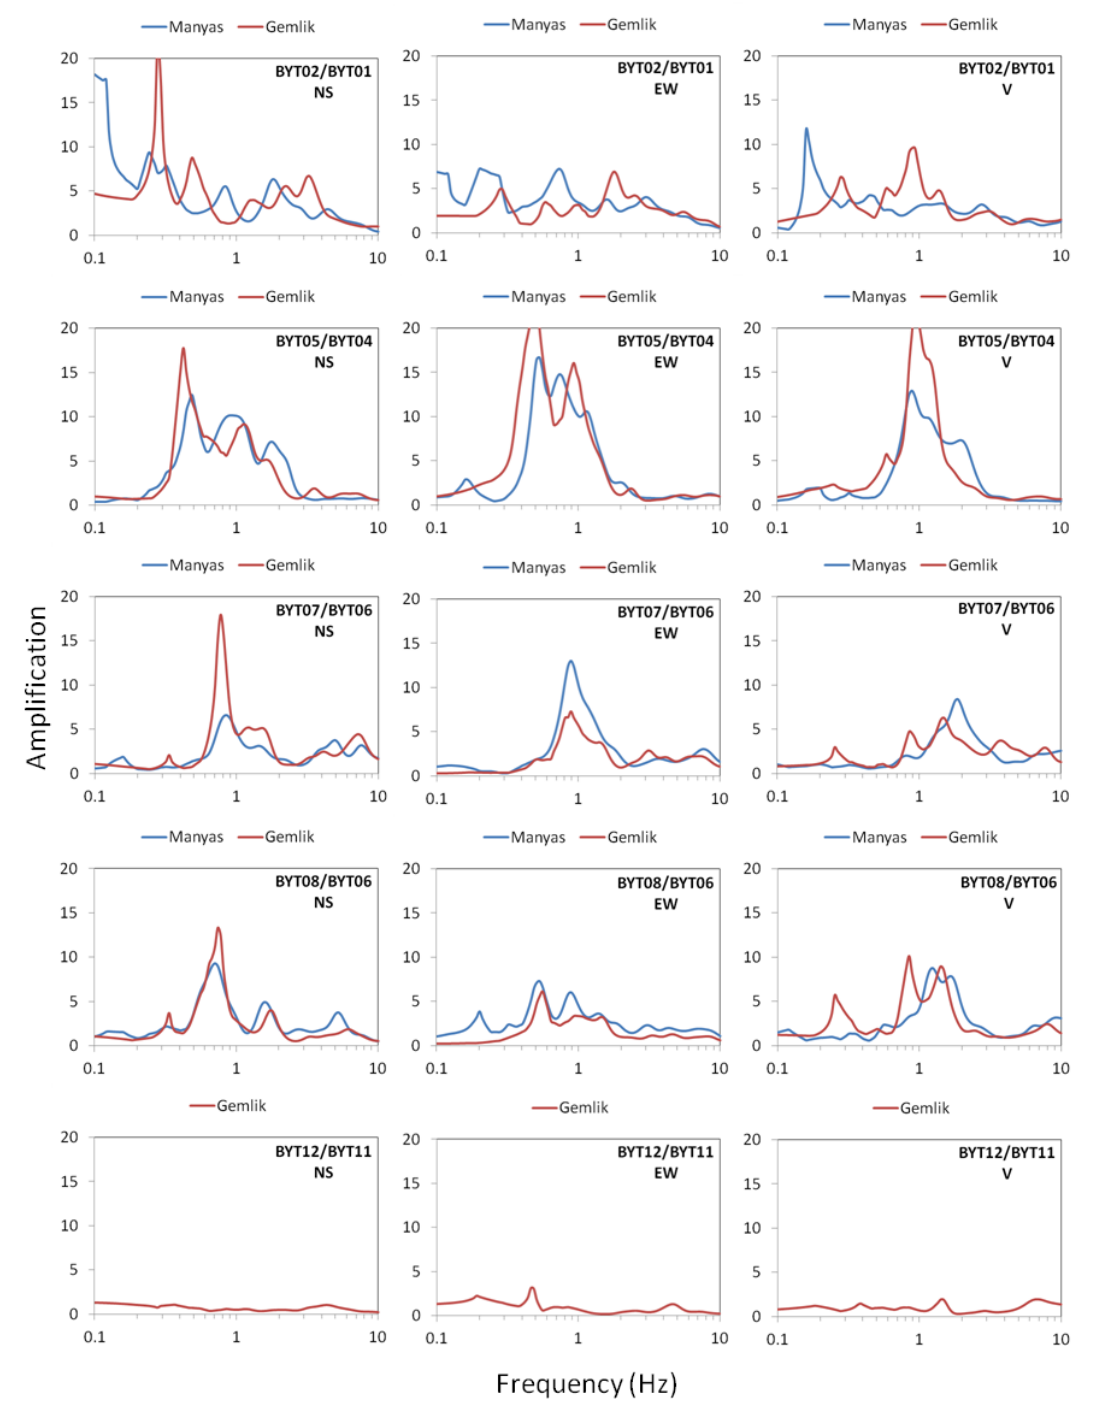
Figure 7. Three component spectral ratios computed for the station couples (BYT01, BYT04, BYT06, BYT11 and BYT12) used as reference for the ones located within basin (BYT02, BYT05, BYT07 and BYT08). Only the surface wave part of the displacement records is used in the ratios. The spectral ratios of Manyas and Gemlik earthquakes are represented by blue and red lines,